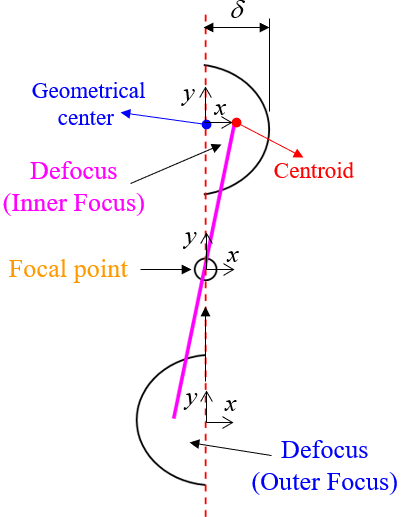
Figure 3. Relation between L and defocus distance δ .